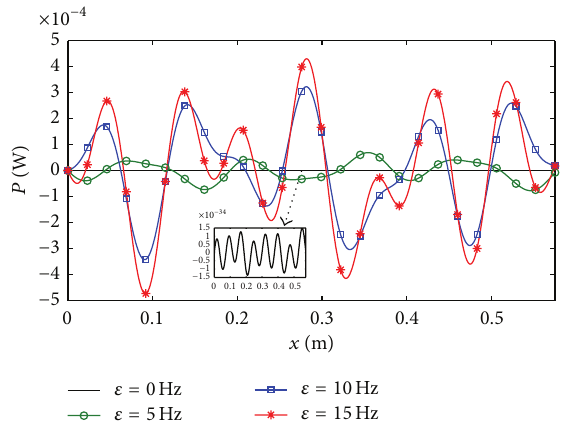
Figure 5: Vibration power flow of the FRMEJ with different disturbance frequencies.